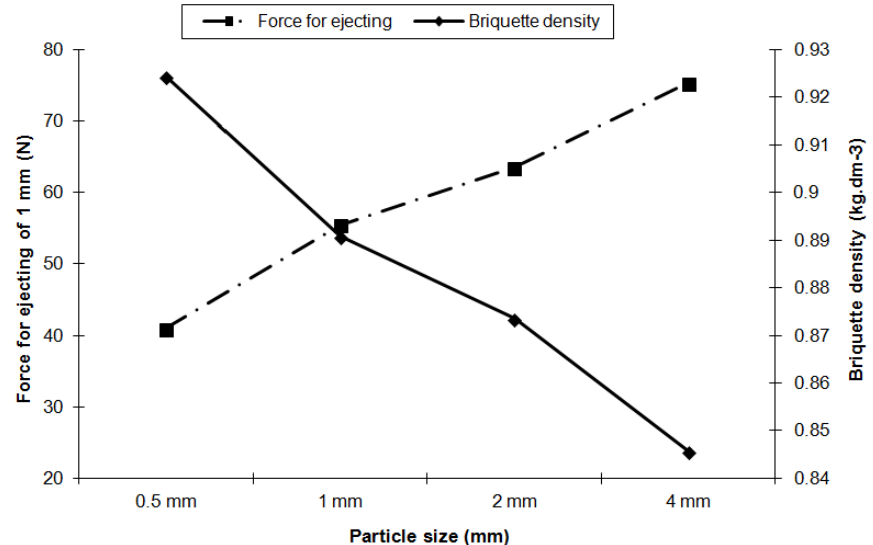
Figure 12. Cumulative interdependence—force required for ejecting, briquette density, and particle size ( w r = 8%; T = 25 °C) at 95 MPa.